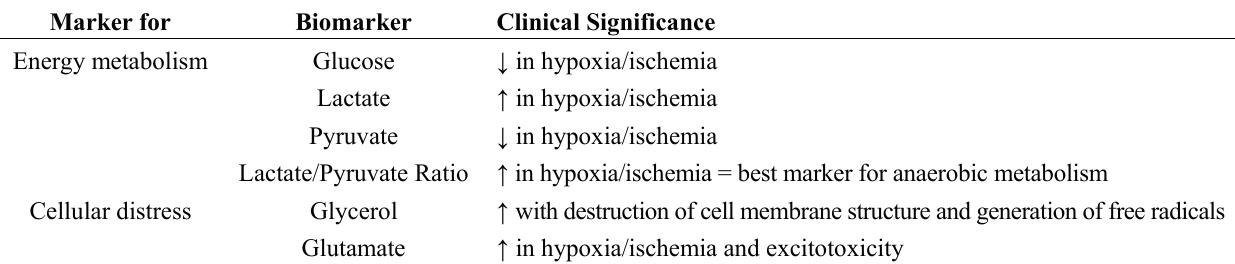
Table 5. Clinically used microdialysis biomarkers